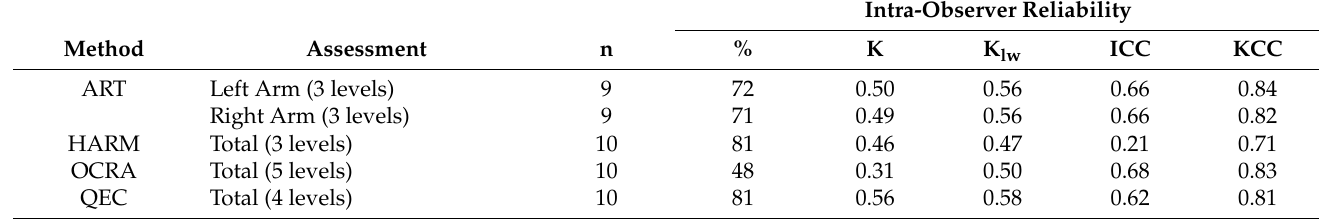
Table 8. Intra-observer reliability of risk levels, with standardized work task duration, using 3 h 45 min for all ten work tasks . Number of ergonomists (n), proportional agreement (%) mean Cohens kappa (K), linearly weighted kappa averaged over pairs (K lw ), intraclass correlation (ICC) and Kendall’s coefficient of concordance (KCC) for the results of the ergonomists’ ratings of the ten different video- recorded work tasks. The ratings were first used to compute the score for each method and then converted into risk